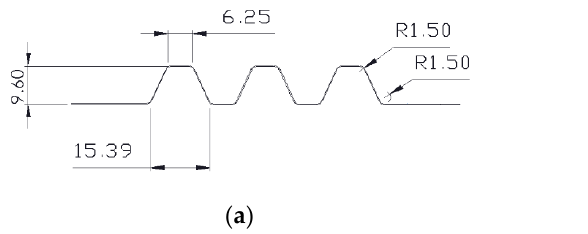
( b ) Figure 1. Flow channel features with fillet radii of ( a ) 0 and ( b ) 0.70 mm.